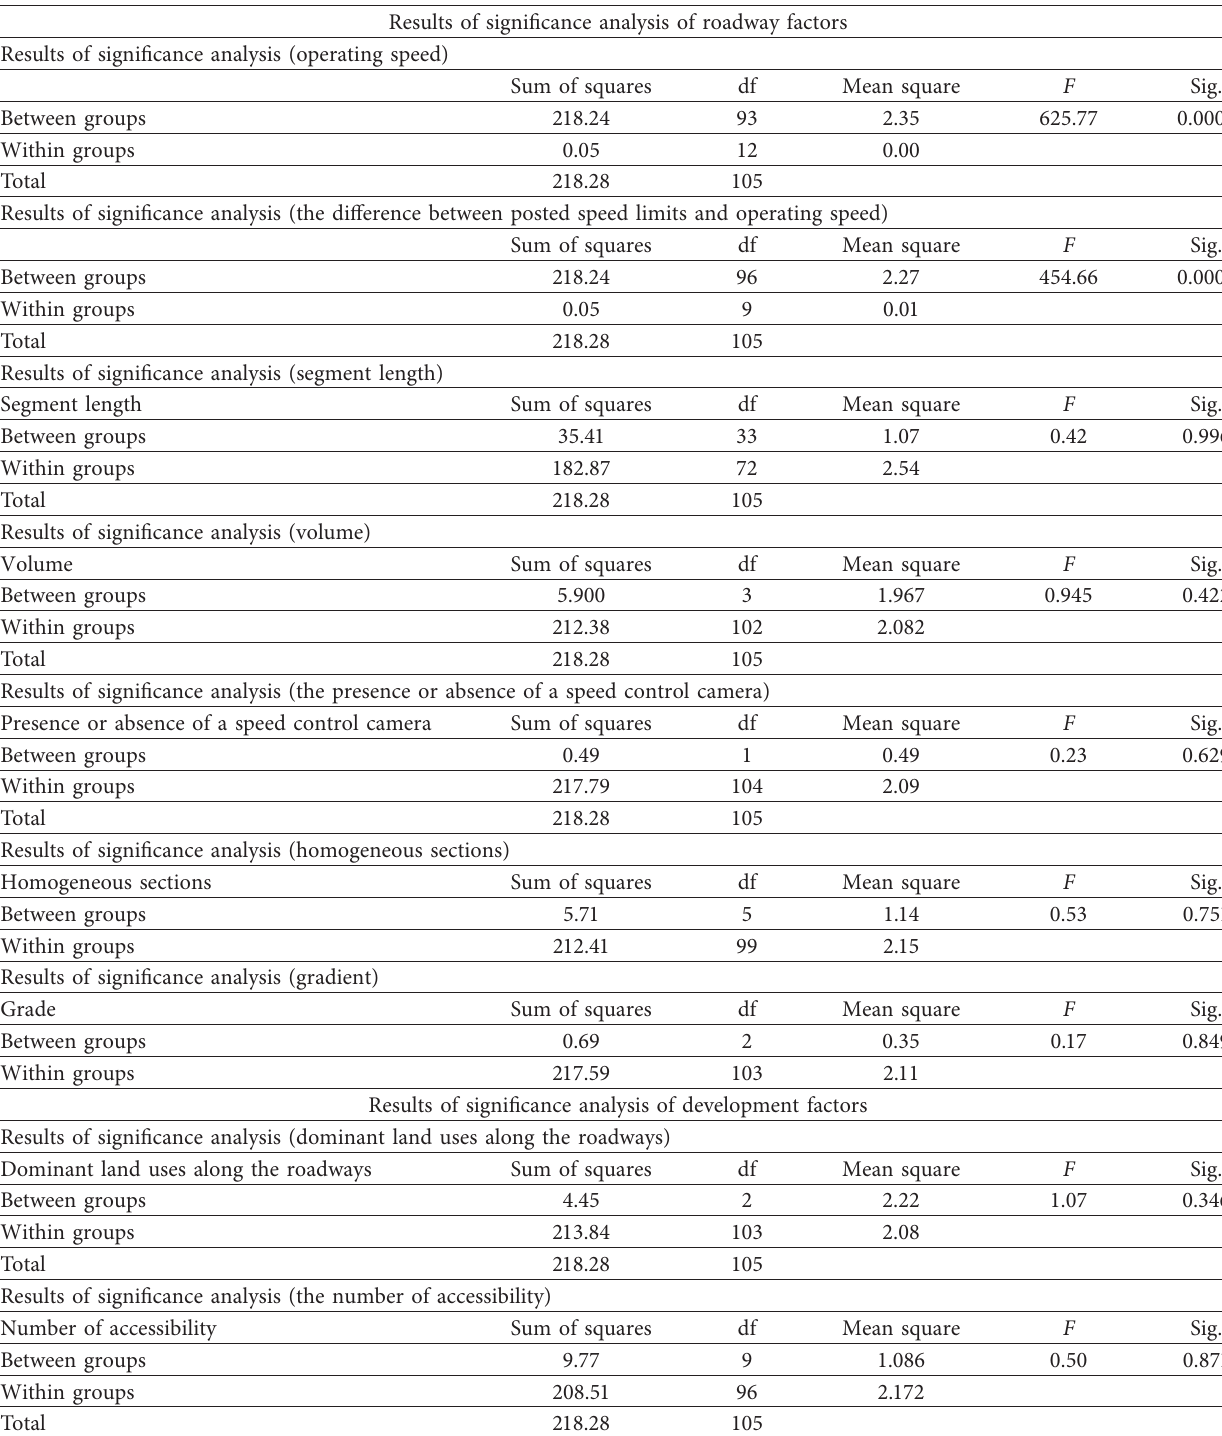
Table 2: ANOVA test for the examination of the effect of roadway and development factors on the accident frequency rate. Results of significance analysis of roadway